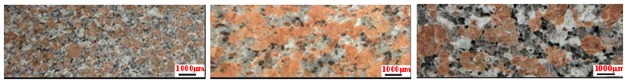
Granites with three kinds of grain sizes processed by digital image.(a) grain size = 1.01mm (b) grain size = 2.12mm (c) grain size = 3mm.